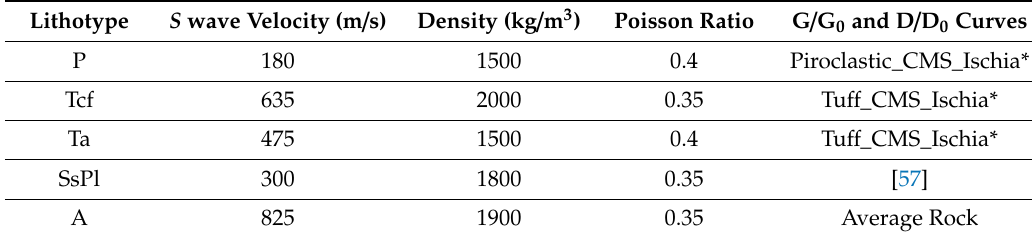
Table 5. Mechanical and dynamic lithotype parameters assigned to each lithological unit used for the computational analysis. The curves marked by an asterisk are from the Level 3 Seismic Microzonation of Casamicciola Terme, Lacco Ameno, and Forio (Ischia Island, Naples) (http: // www. commissarioricostruzioneischia.it).